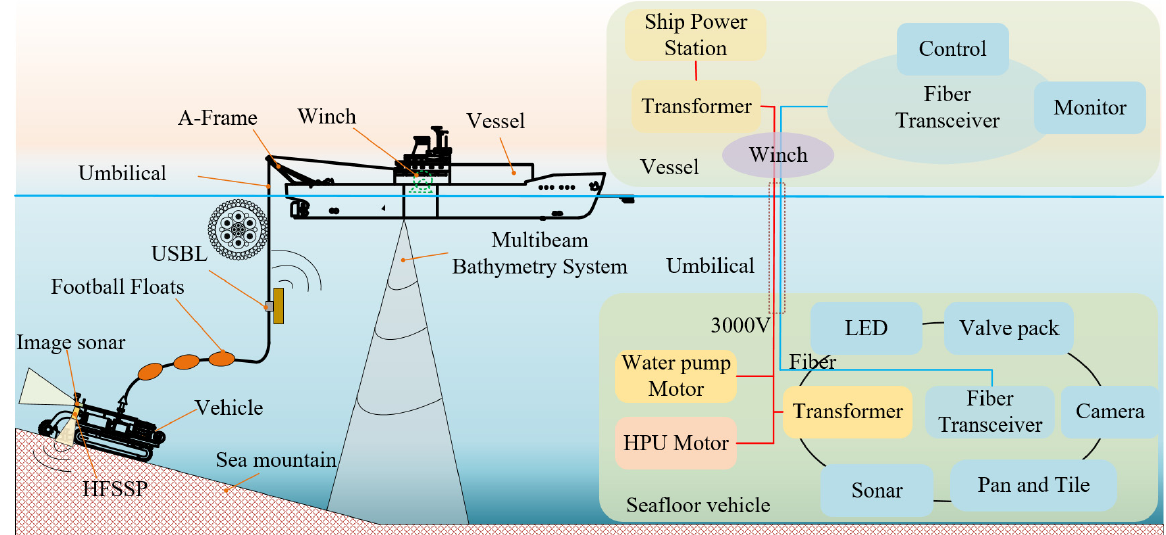
Figure 9. Left: schematic diagram of mining test system; Right: structure of the electrical system.